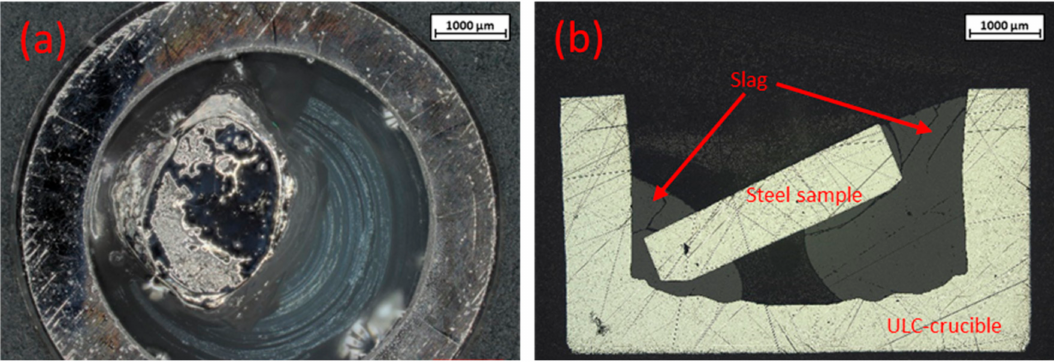
Figure 8. Microscopic evaluation of two crucibles: ( a ) with high depth of focus; ( b ) cross section.